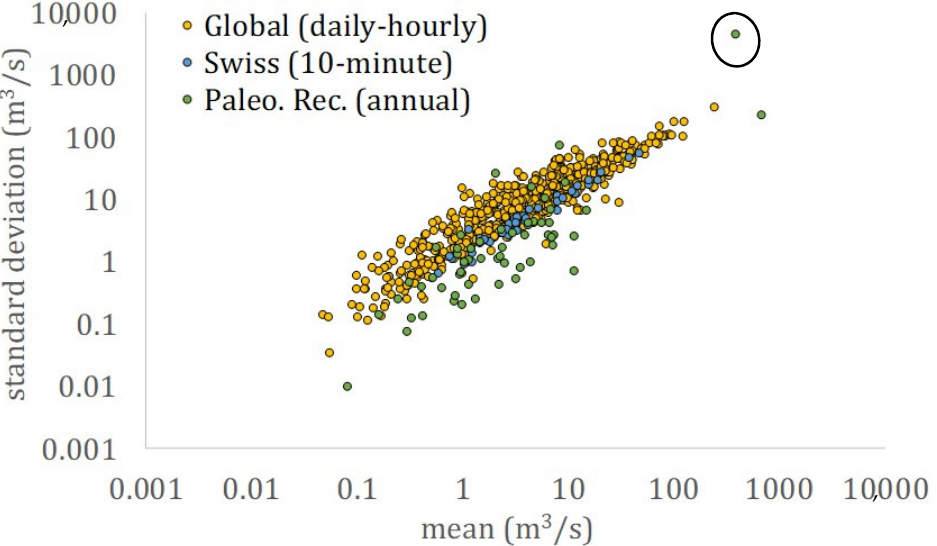
Figure 2. Mean vs. standard deviation of streamflow time series from the analysis by Dimitriadis et al. [6] (daily and hourly time series, denoted as Global ), for the Swiss dataset (10 min resolution, denoted as Swiss ) and for the paleoclimatic reconstructions (annual time series, denoted as Paleo. Rec. ).